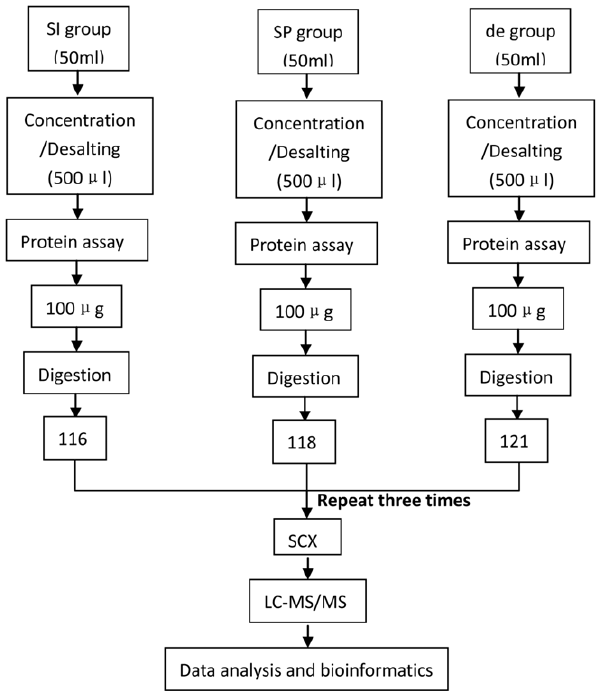
Figure 1. Schematic of the experimental design based on iTRAQ labeling combined with 2-D LC-MS/MS analysis of SI, SP, and de. SCX, strong cation exchange. SI: urine specimens from patients with SIRS. SP: urine specimens from sepsis patients, acquired within 24 h of admission to the ICU. de: urine specimens from sepsis patients, acquired within 48 h before